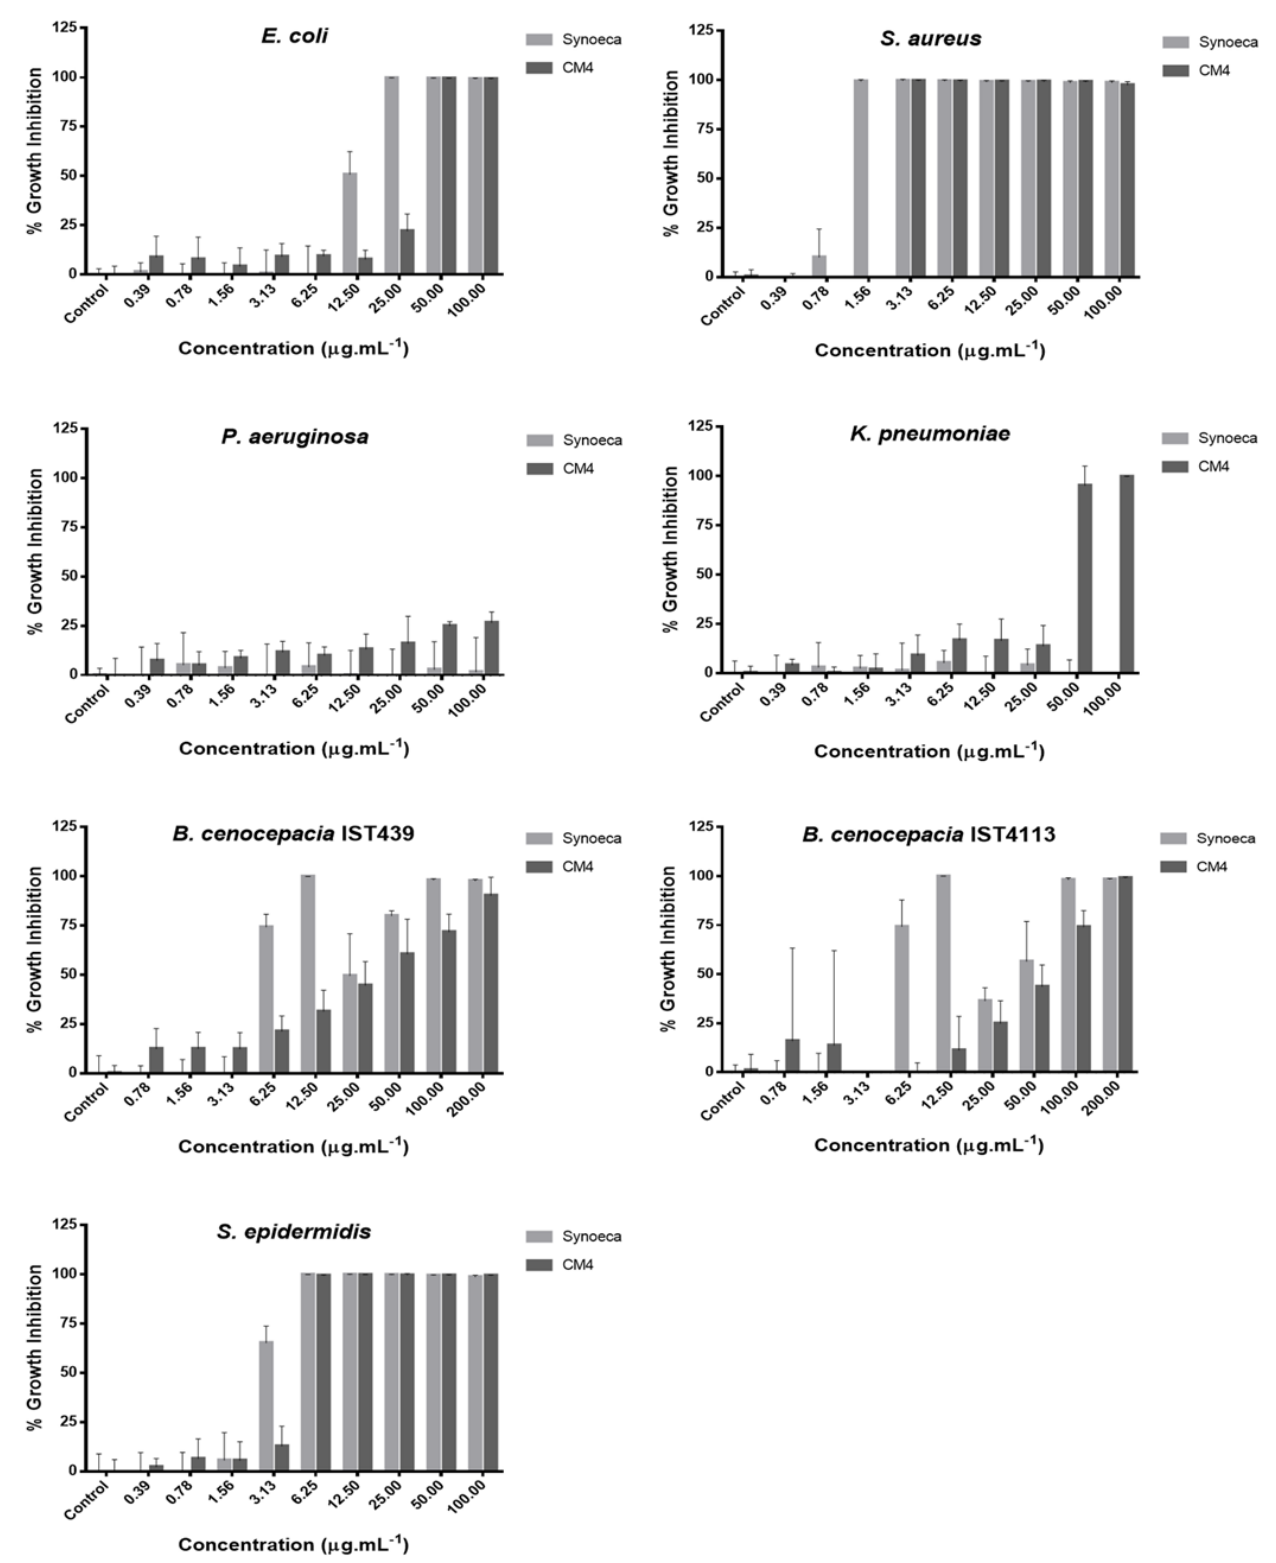
Figure 5. Antibacterial activity of Synoeca (light grey) and CM4 (dark grey) against different bacteria after 18 h of incubation at 37 °C. Bars indicate the mean of at least three replicates ± standard deviation (SD).